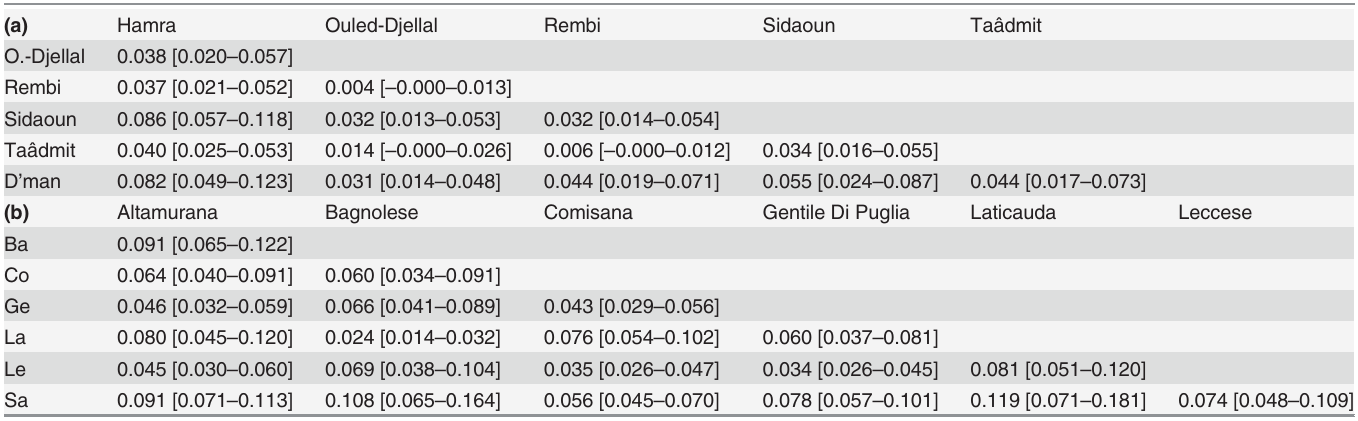
Table 3. Pair-wise F ST among Algerian breeds (a) and Italian breeds (b), calculated with a common set of 15 microsatellites * (with confidence inter- vals at 95%).